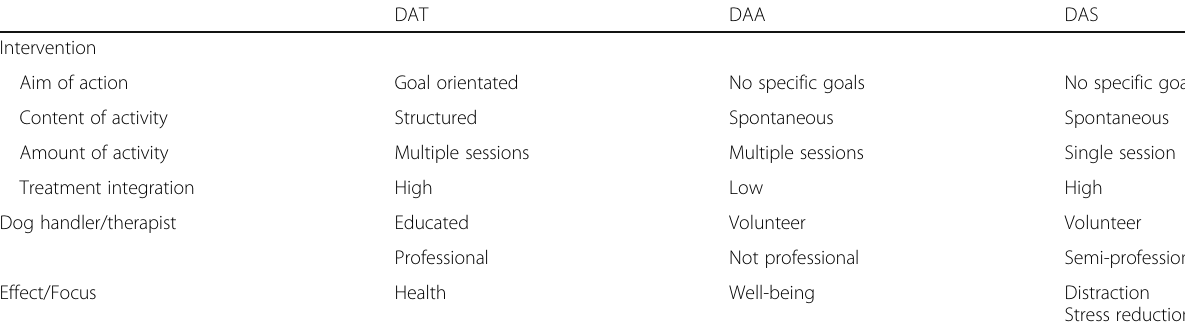
Table 2 Criteria for categorization of interventions